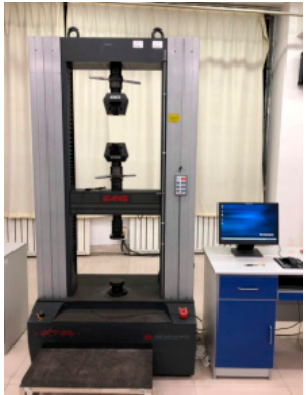
Figure 1. The AG-X250 Shimadzu Precision Universal Test.